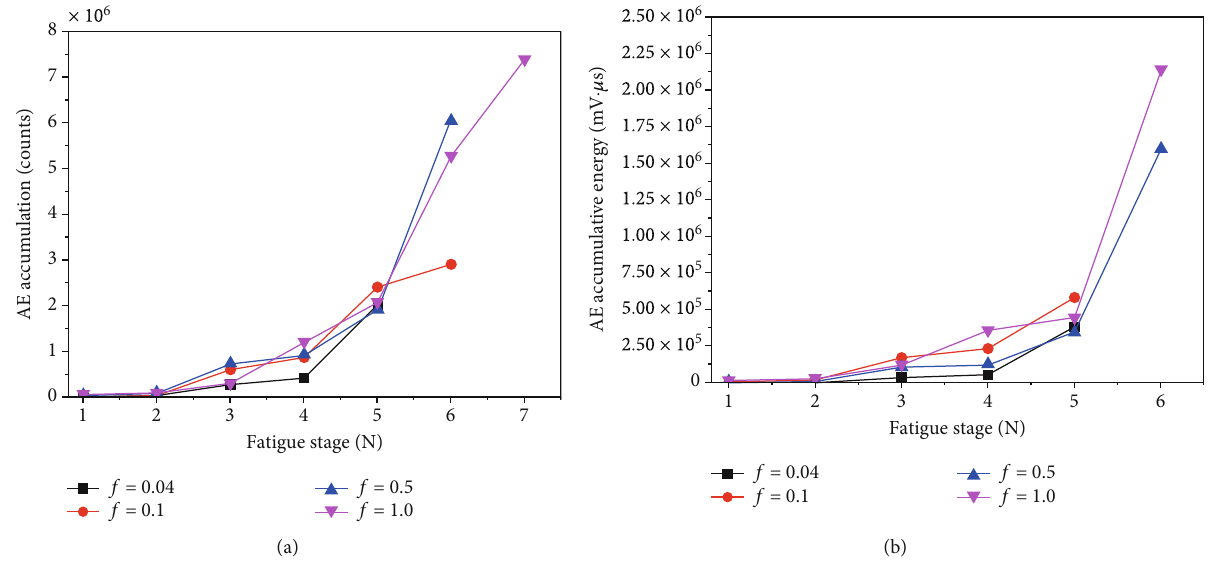
Figure 6: Depict the AE accumulative counts (a) and AE accumulative energy (b) with the fatigue loading